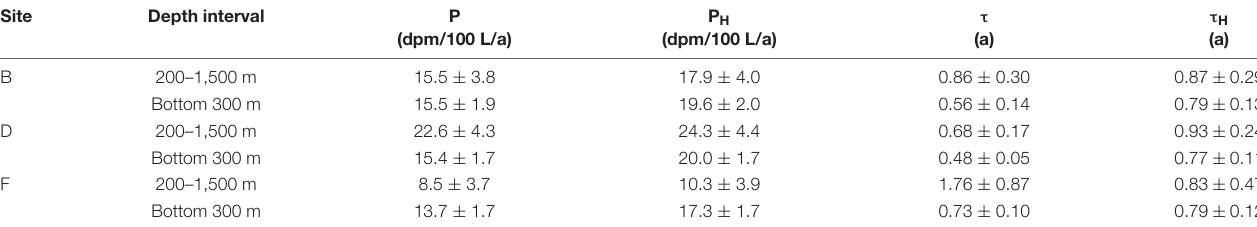
TABLE 3 | Removal rate and residence time of a total 210 Po under ignoring and considering horizontal transport.